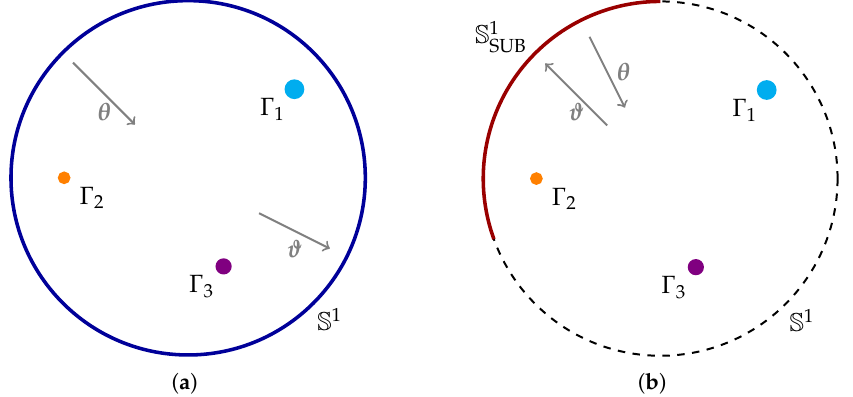
Figure 1. Schematic diagram of full- and limited-view inverse scattering problems. ( a ) Full-view situation; ( b ) Limited-view